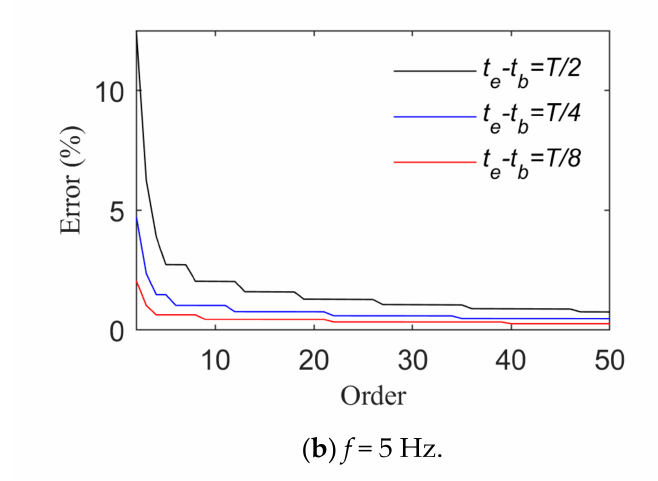
Figure 8. Fitting effects of triangular wave loads (Case 2). Figures 9 and 10 show comparisons between the real and fitting curves of triangular wave signals (1 Hz and 5 Hz) in the case of the tenth order fitting by means of power and trigonometric series fitting, respectively. They indicate that real and fitting errors focus on peaks or troughs primarily due to non-differentiable properties at these positions of the triangular wave signals. Smooth basis function-based fitting only leads to approximation rather than accessibility. Growth of the number of fitting items of the basis function can reduce fitting errors but increase the amount of load identification calculations.